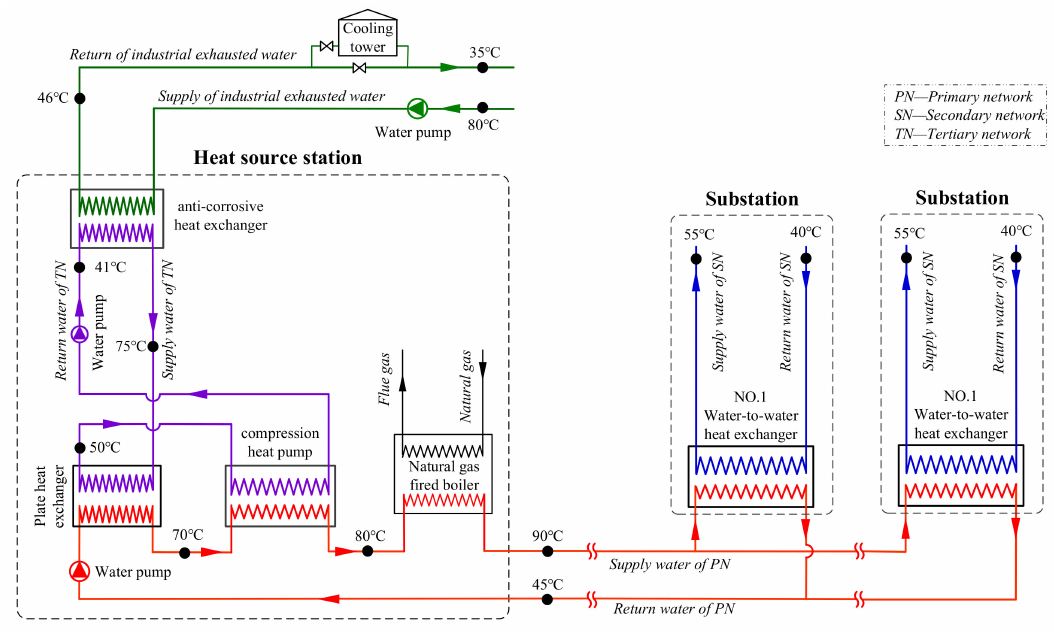
Figure 3. Sketch of central heating system integrated with industrial exhausted heat using centralized electric compression heat pumps